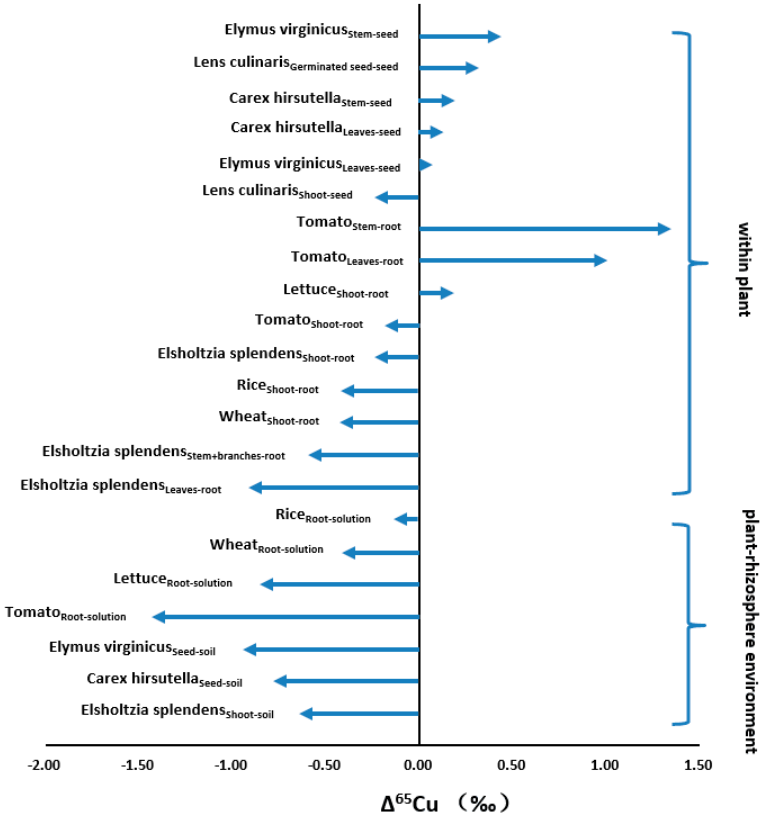
Figure 3. Cu isotopic fractionation factors ( Δ 65 Cu) during soil-plant uptake and within-plant processes [18,84,95,97].